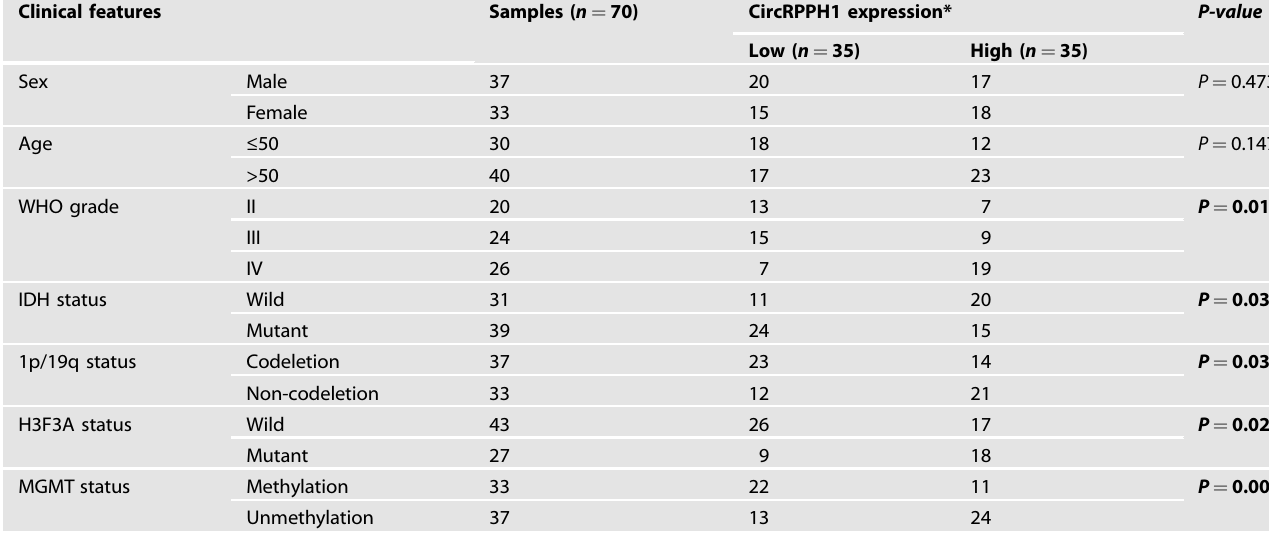
Table 1. Relationship of circRPPH1 expression to clinical features of glioma